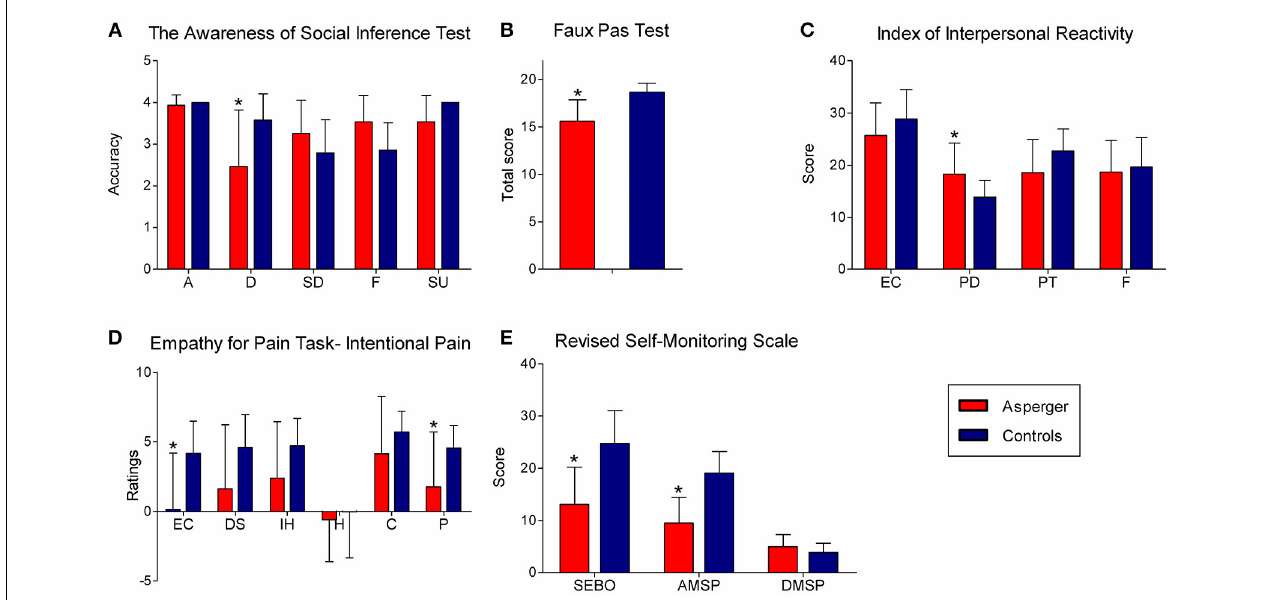
FIGURE 2 | Pattern of performance of adults with AS in social cognition tasks. Adults with AS were impaired in tasks that involved implicit encoding and automatic integration of contextual cues to interpret a given social situation. Conversely, they performed as well as controls in tasks which